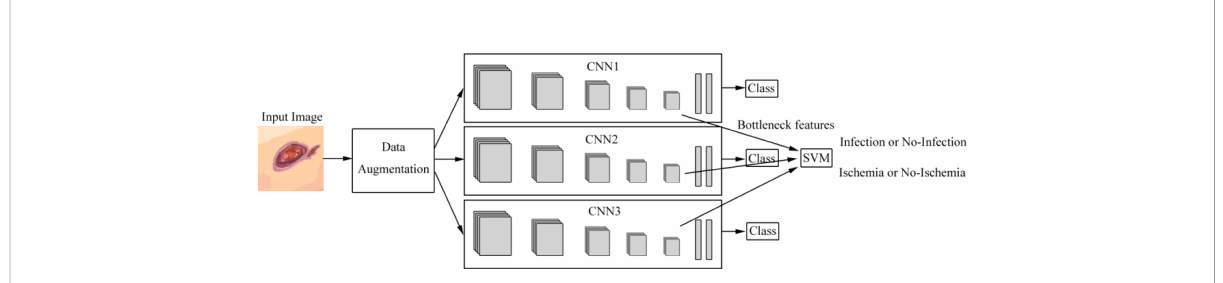
FIGURE 4 Overview of the architecture based on ensemble CNNs in literature (28). Features are extracted from CNNs and are fed into the support vector machine (SVM) classi fi er to perform the classi fi cation of infection or no infection, ischemia or no ischemia.